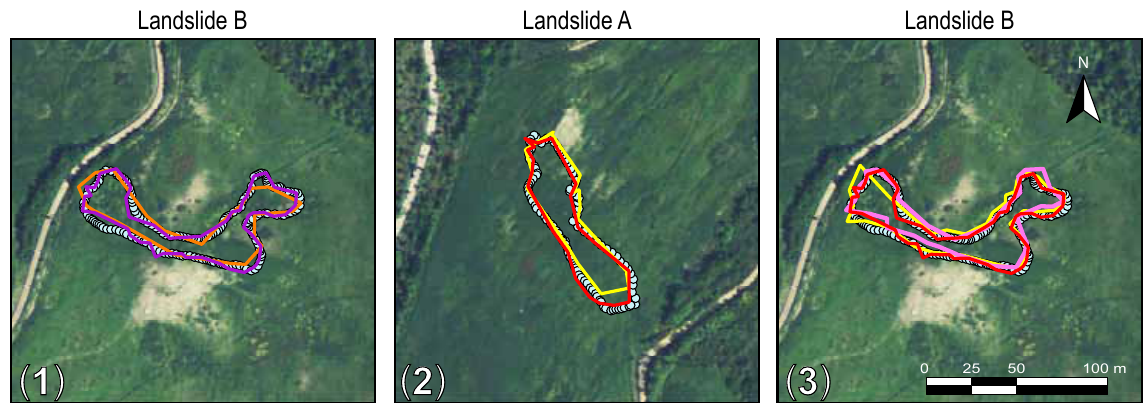
Fig. 4. Comparison of maps prepared for two landslides in the Monte Castello di Vibio area, Umbria, Central Italy. (1) Two mappings prepared by the same operator using the rangefinder binocular and GPS from a distance of ∼ 2.5km (orange), and from a distance of ∼ 250m (violet). (2) Mappings performed by two operators (yellow and red lines) using the rangefinder binocular from a distance of ∼ 2.5km. (3) Mappings obtained by three operators (yellow, red, and pink lines) using the rangefinder binocular and GPS from a distance of ∼ 250m. In all maps, light blue dots show data obtained by walking the GPS receiver along the landslide perimeter.